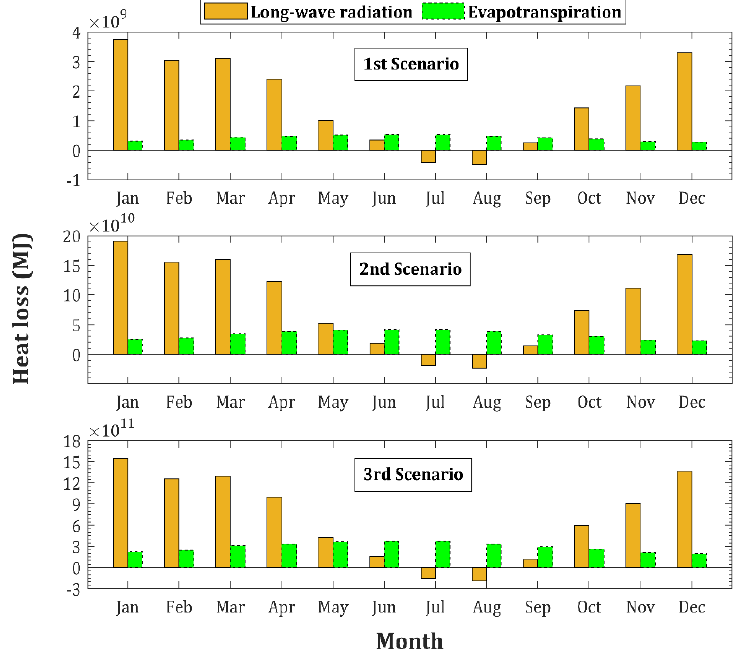
Figure 14. Monthly values of heating losses through long-wave radiation and evapotranspiration.